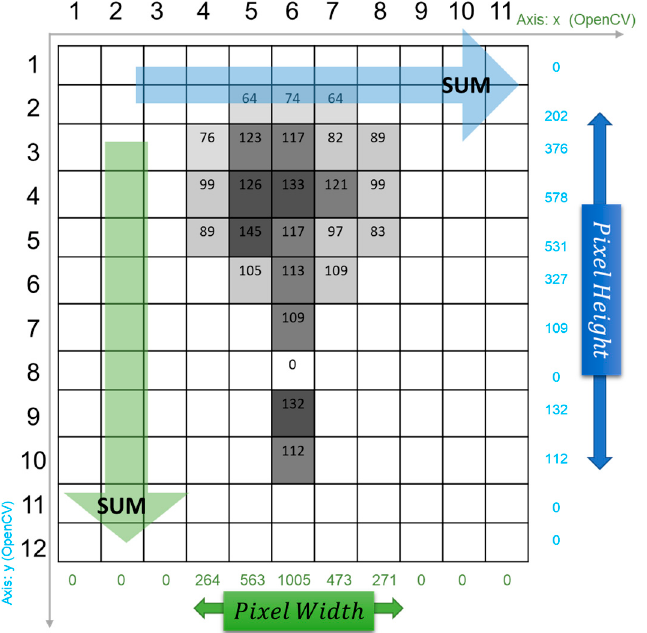
Figure 5. Brief illustration of the masked and flooded stop sign measurement calculation process on the pixel level using Python with a 11 × 12 array.